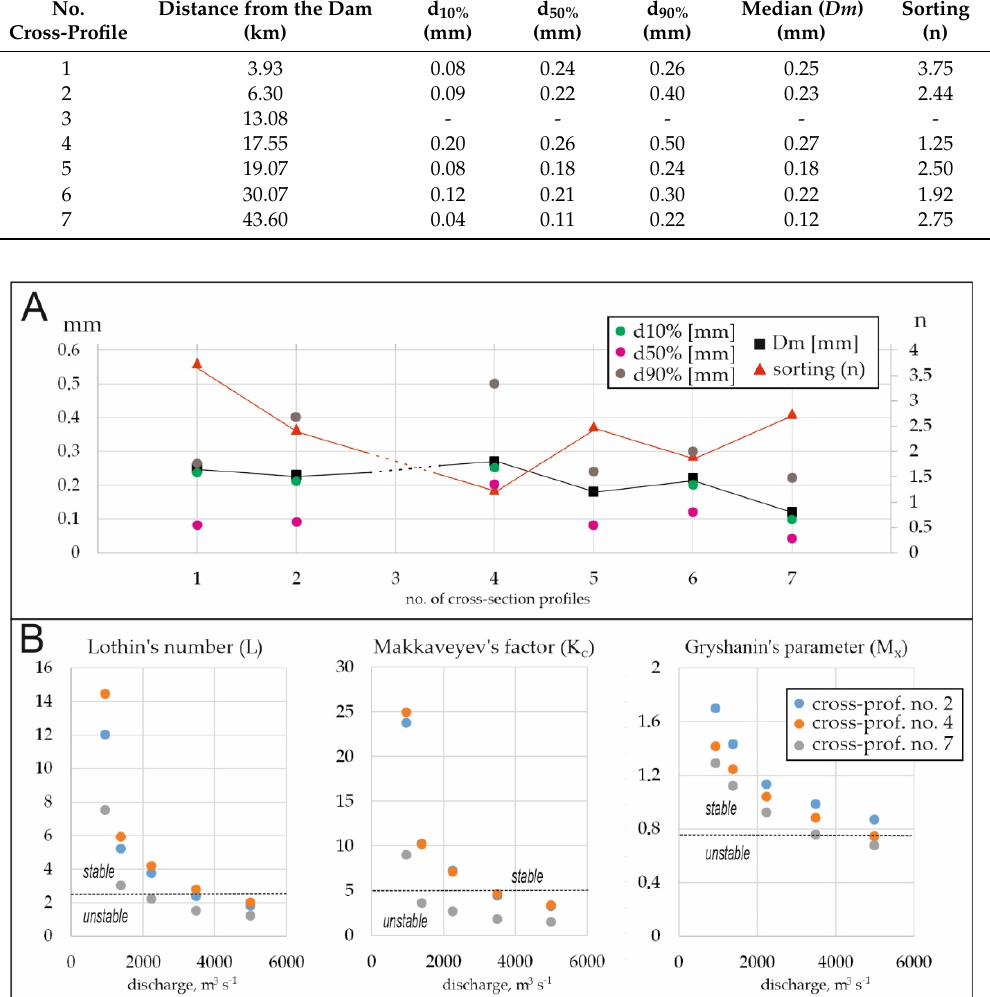
Figure 4. Characteristic sediment particle size composition ( A ) and morphological indicators of stability ( B ) of the Dnieper channel for monitored cross-profiles.